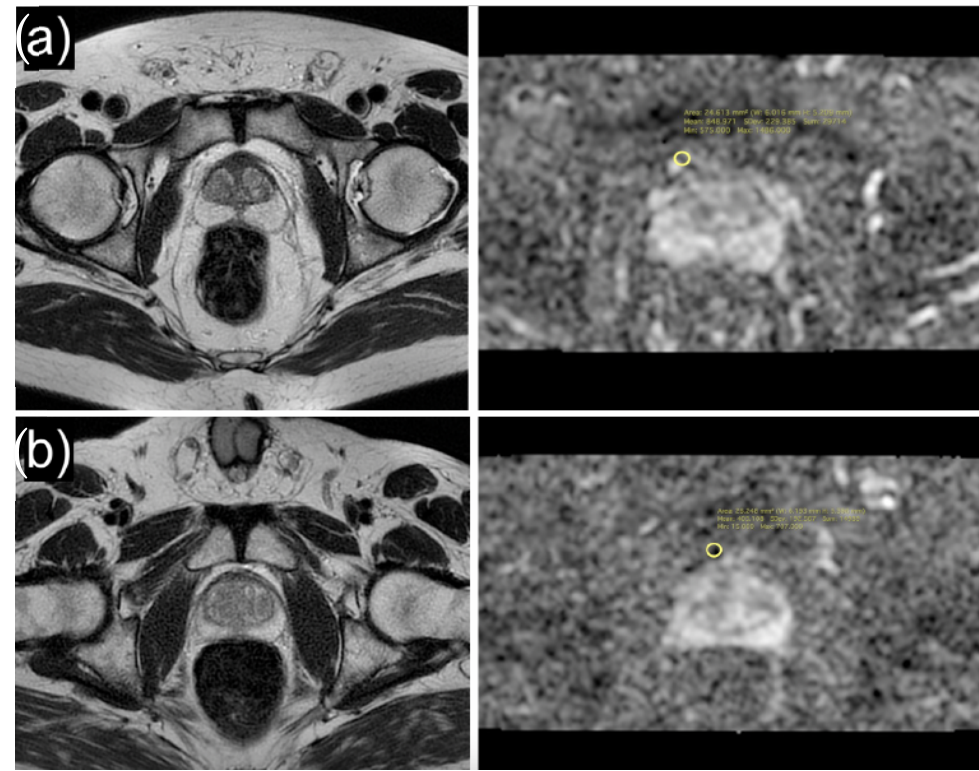
Figure 1. Axial T2-weighted image and ADC map of a 71-year-old patient with high ADC values (mean: 848.9 × 10 − 6 mm 2 /s) of periprostatic adipose tissue ( a ), and axial T2-weighted image and ADC map of a 64-year-old patient with low ADC values (mean: 405.1 × 10 − 6 mm 2 /s) of periprostatic adipose tissue ( b ).